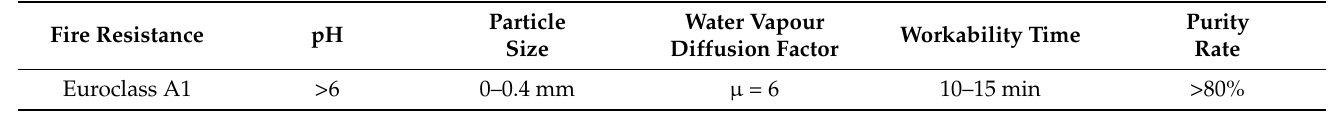
Table 1. Physical properties of fine gypsum YF-B1. Source: Saint-Gobain Placo.